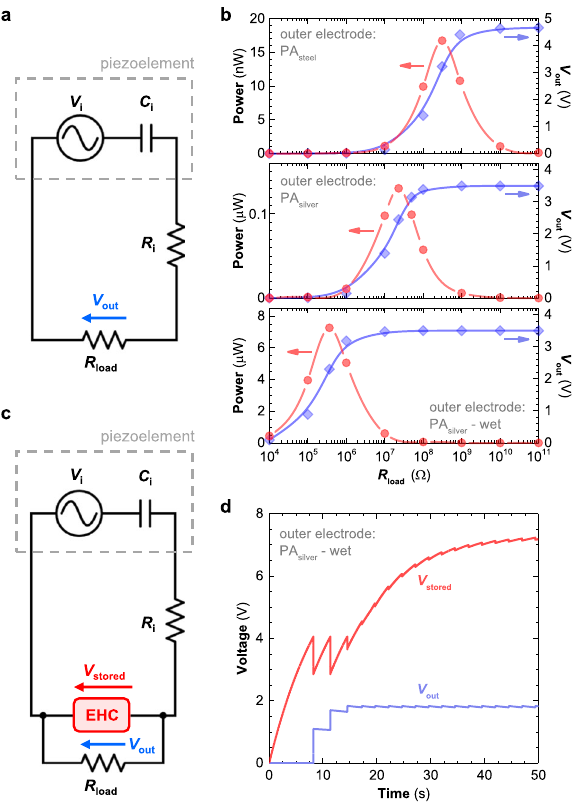
Fig. 4 Equivalent circuits of piezoelectric textiles, and predicted output voltage and power. a Equivalent electric circuit of the woven piezoelectric textiles with conducting yarns as outer electrodes. b Predicted output peak voltage V out (blue) and power (red) of textiles produced with PA steel (top: V i = 4.7 V; C i = 0.26 nF; R i = 4935 k Ω ); PA silver (centre: V i = 3.5 V; C i = 3.5 nF; R i = 100 k Ω ); and PA silver -wet (bottom: V i = 3.5 V; C i = 220 nF; R i = 41 k Ω ); C i and R i were measured, V out and the power were modelled with SPICE software LTspice. c Equivalent electric circuit for a piezoelectric textile connected to an energy harvesting circuit (EHC). d Predicted charging voltage stored in the EHC, V stored (red), and output voltage V out (blue); outer electrodes PA silver -wet ( V i = 3.5 V; C i = 220 nF; R i = 41 k Ω ; R load = 1 M Ω